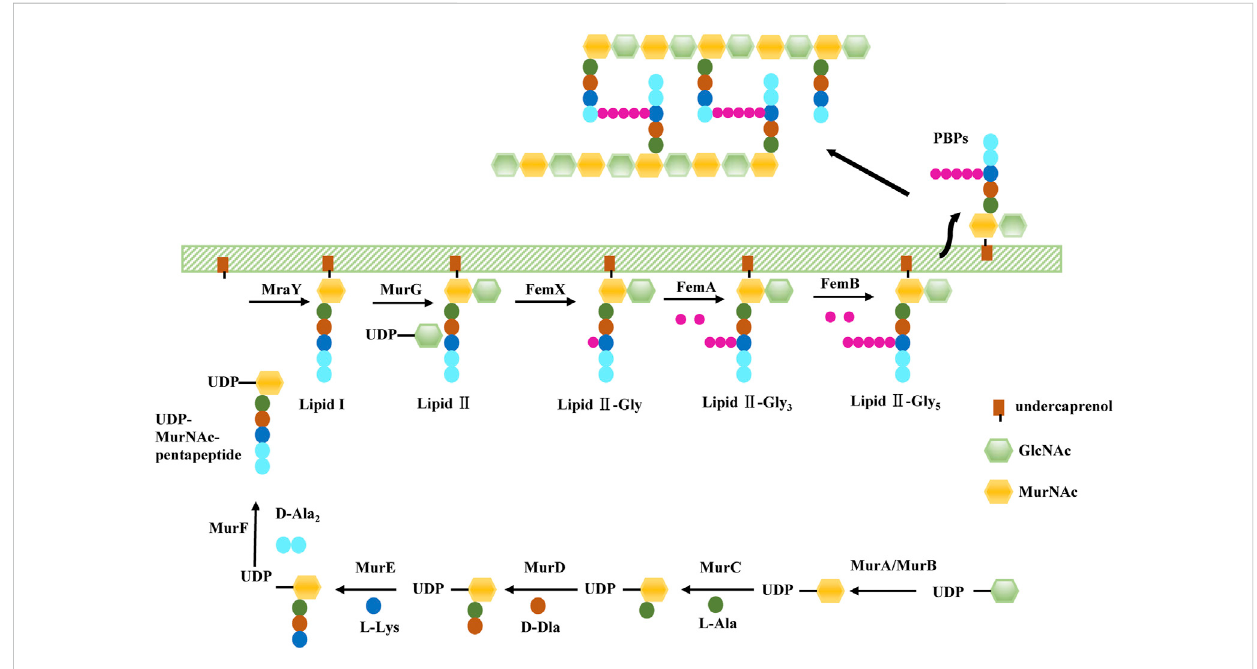
The biosynthesis of S. aureus cell